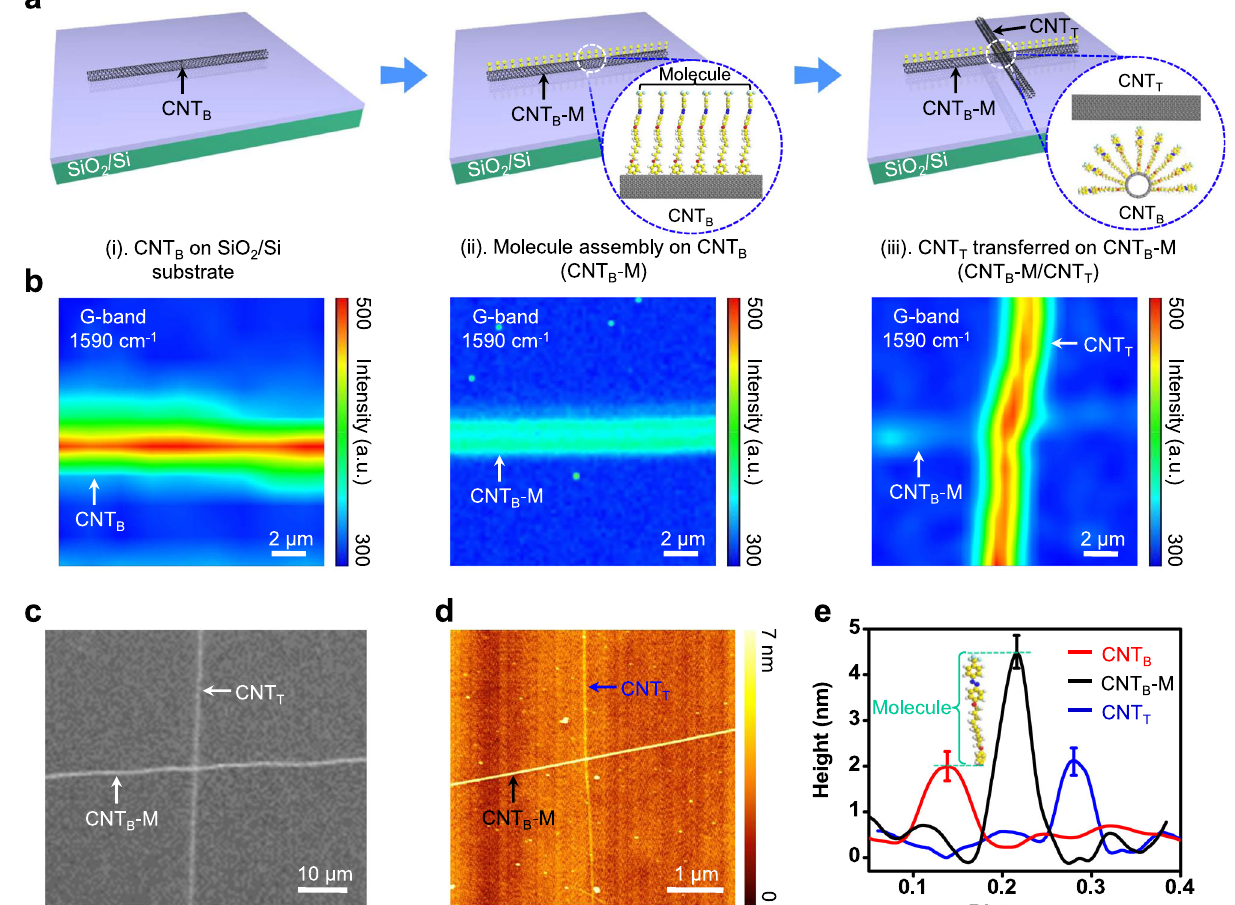
Fig. 1 | Device fabrication process and characterizations. a Schematics of the fabrication steps for the CNT B -M/CNT T vdWI device (1×1 CNT array). The inset imagein(ii)and(iii)showstheschematicsofthemoleculeassemblyonCNT B . b The Raman mapping corresponding to each step in ( a ), where the G-band (1590cm − 1 ) peaks are observed at a laser wavelength of 532nm. c The SEM images for the